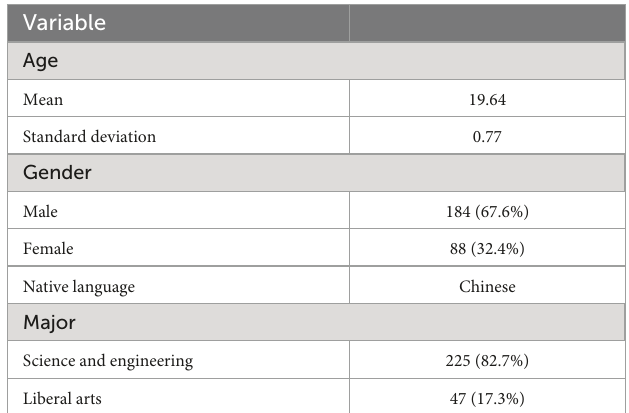
TABLE 1 Demographic information for a sample of second-year undergraduate